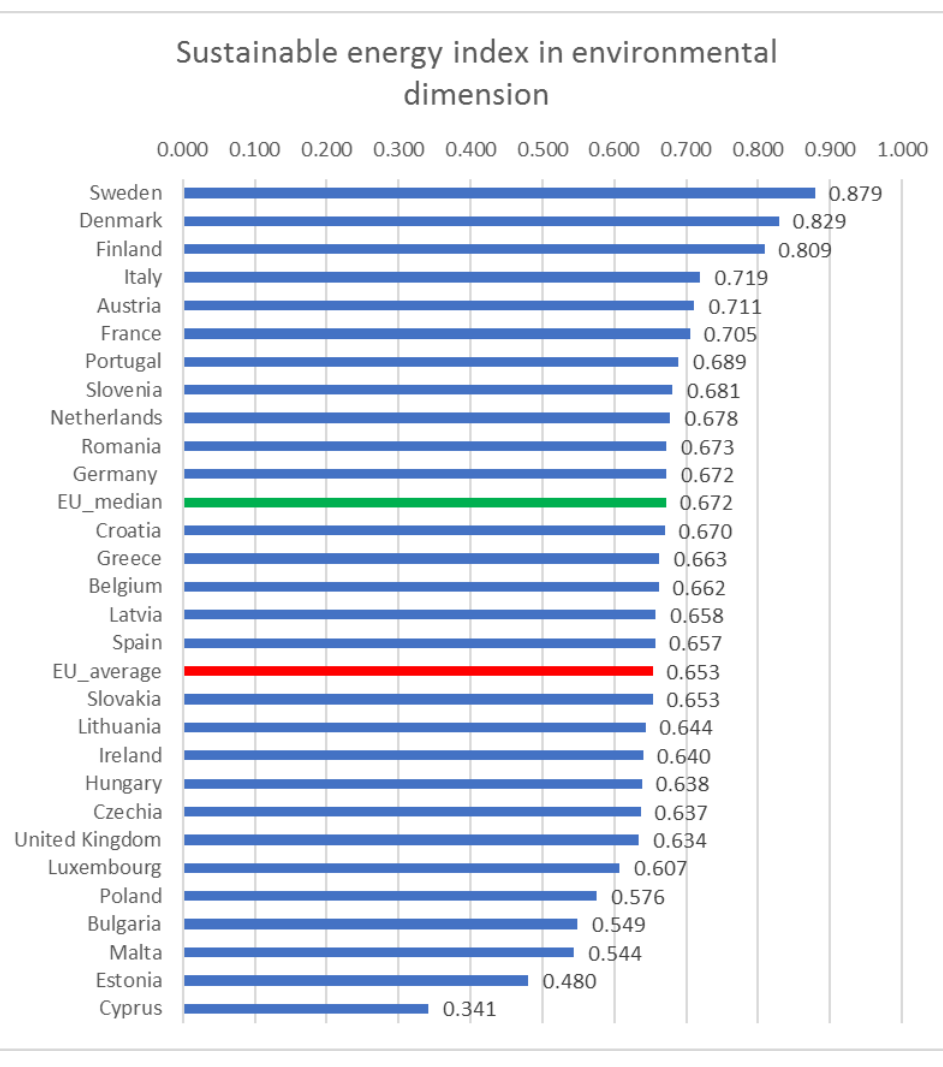
Figure 3. Environmental dimension index of sustainable energy in 2017 for the EU-28 Member States.